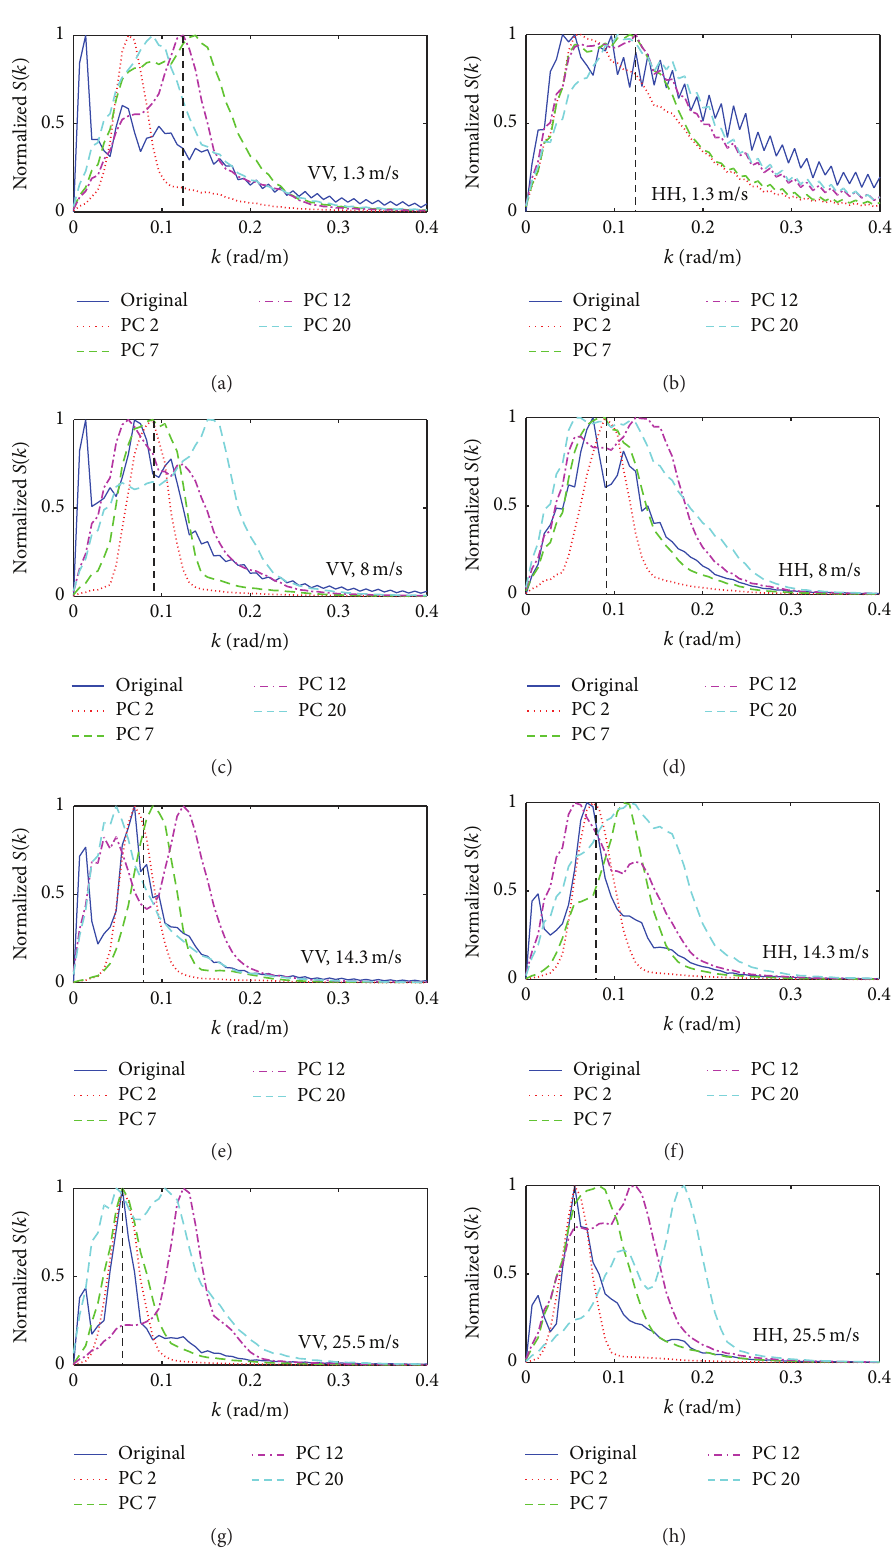
Figure 8: The normalized wavenumber spectra of different principal components of HH and VV polarized X-band marine radars, at the wind speeds of ((a) and (b)) 1.3 m/s, ((c) and (d)) 8.0 m/s, ((e) and (f)) 14.3 m/s, and ((g) and (h)) 25.5 m/s. The vertical black dashed lines denote the peak wavenumbers measured by the